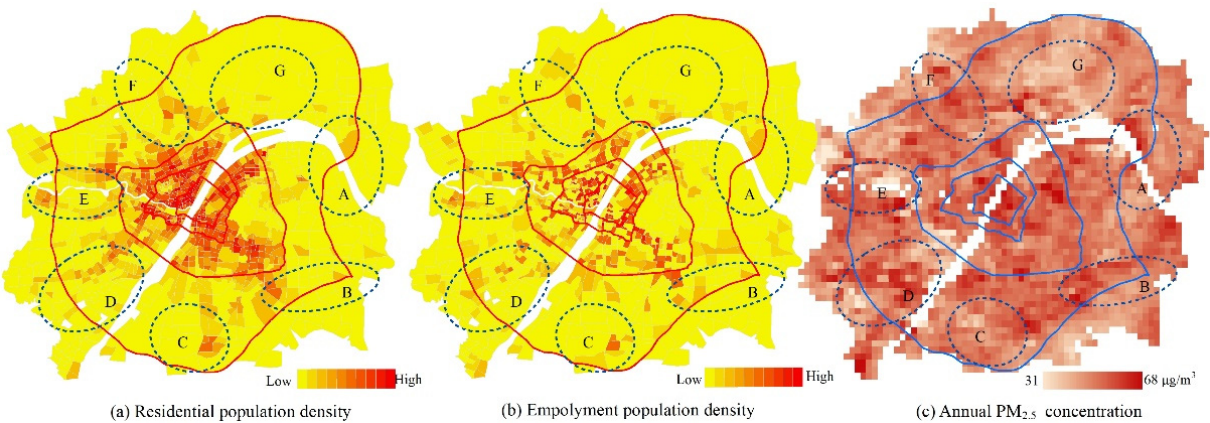
Figure 8. Employment density and PM 2.5 concentration in the Wuhan metropolitan area.